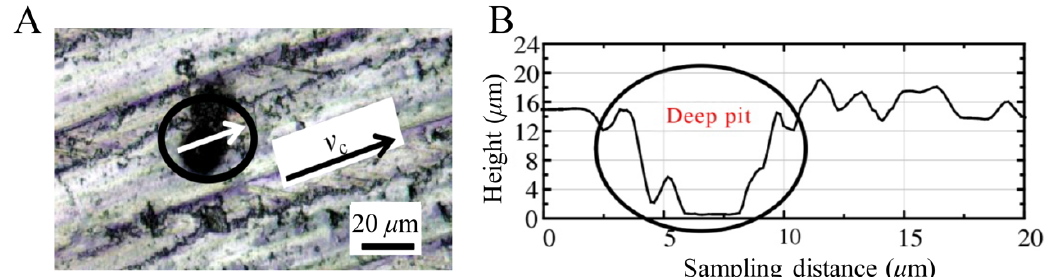
Figure 24. Typical surface deep pit morphology [25]. ( A ) Surface sampling location. ( B ) Two-dimensional morphology.